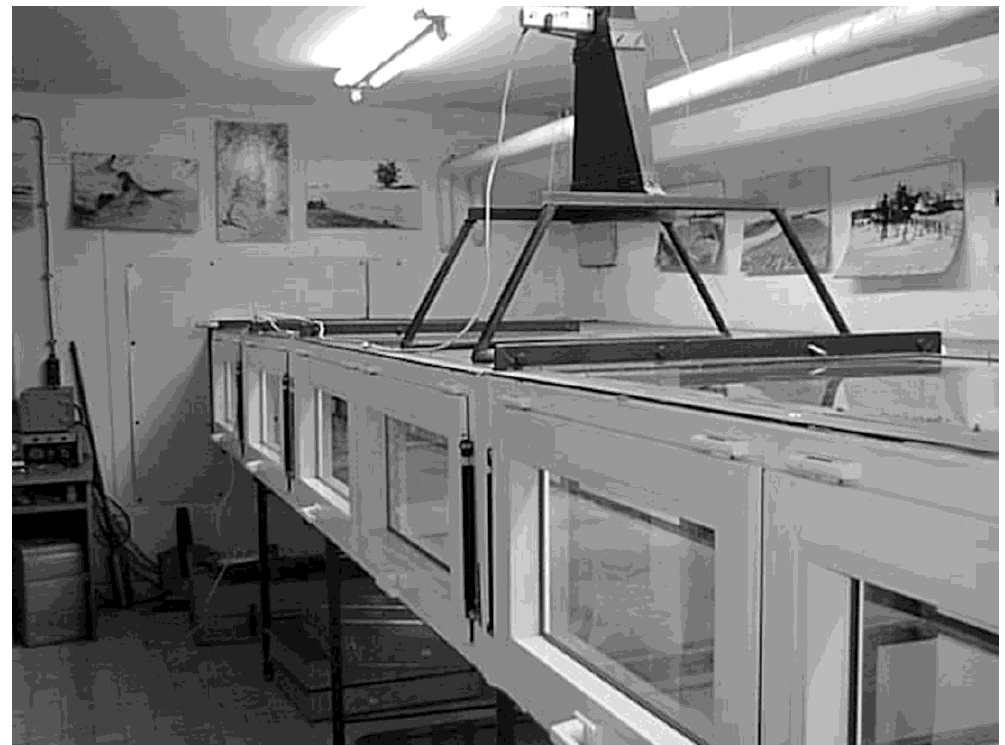
Figure 2. The laboratory wind tunnel used in the experiments for measuring the amount of evaporation loss of soil samples (University of Debrecen, Debrecen, Hungary).